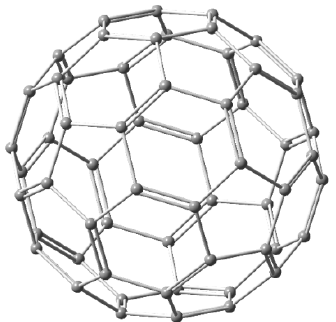
Fig. 7. Optimized structure of C60(ih) by B3LY- P/6-311++G(2d,2p) E(-738.33kJ) Fig 7. Optimized structure of C60(ih) by B3LYP/6-311++G(2d,2p)